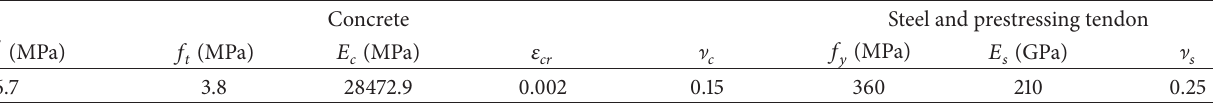
Table 2: Material properties used in the finite element analysis.